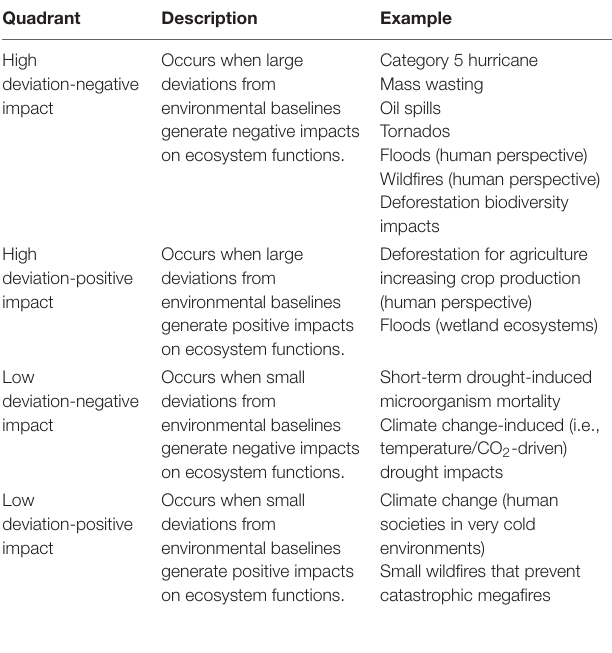
TABLE 1 | Description and examples of the four universal disturbance types generated by the proposed